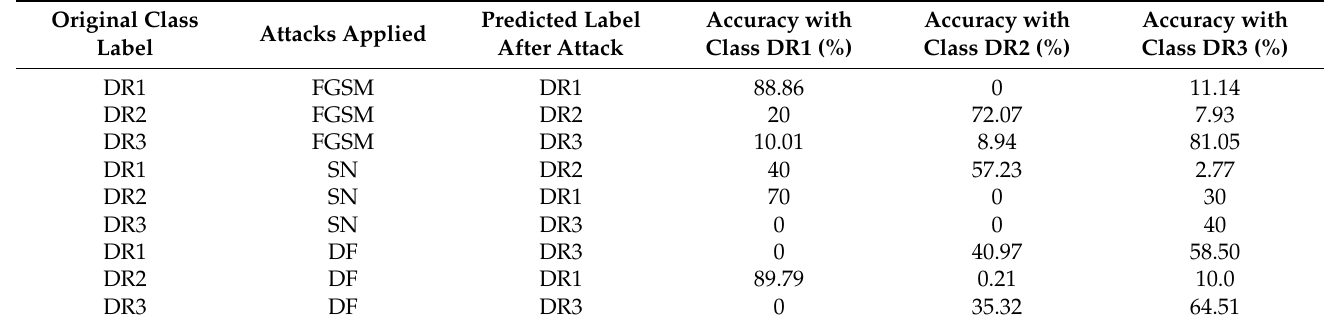
Table 3. Testing of Adversarial Training AT1 Network with Attack Images.